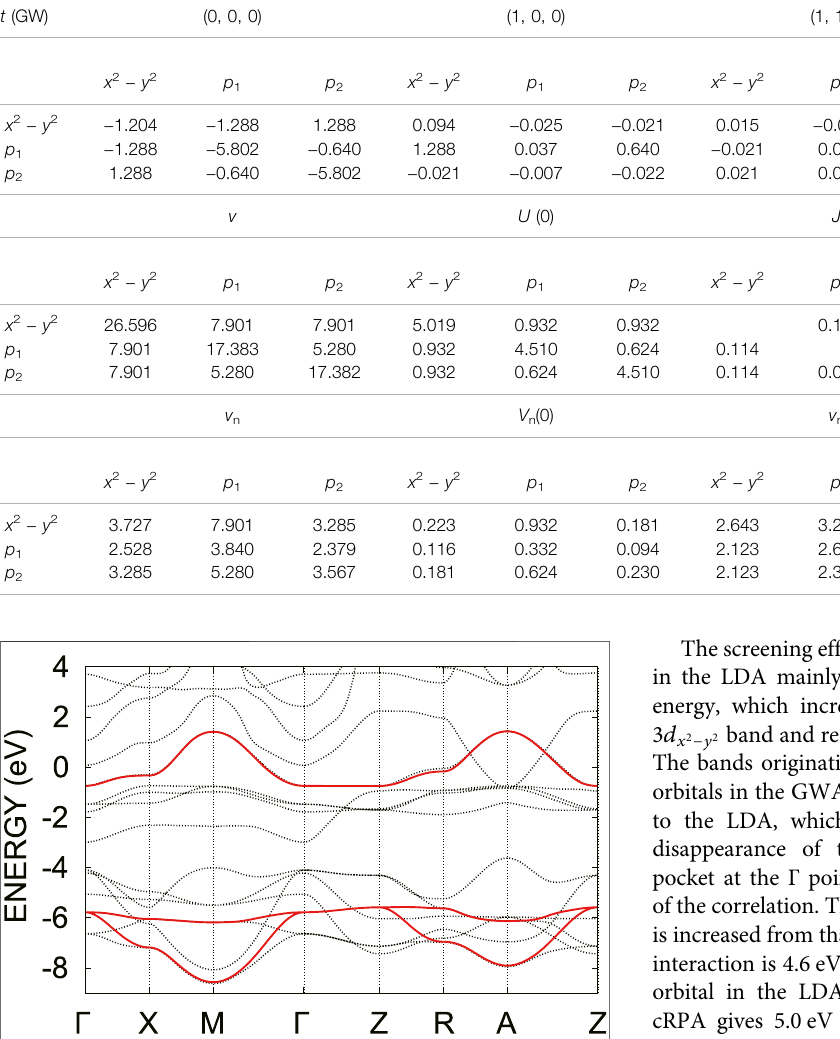
FIGURE 5 | Electronic band structure of the three-orbital model in the GWA (solid lines). The zero energy corresponds to the Fermi level. For comparison, the band structures in the GWA is also given (dotted